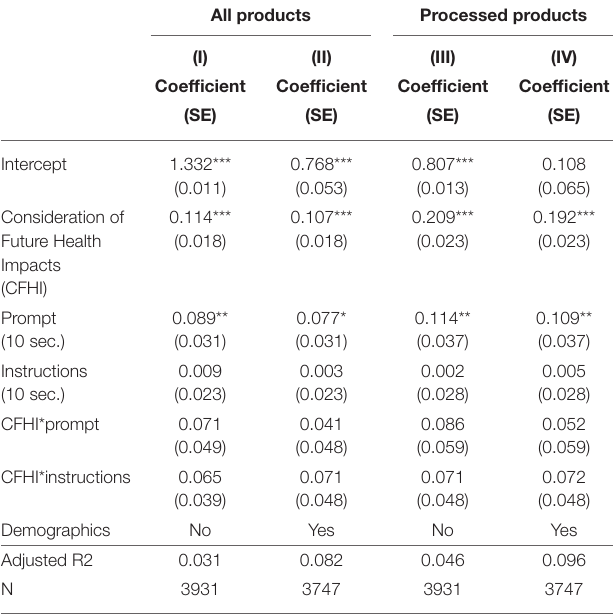
TABLE 6 | The impact of consideration of future health impacts and fiber prompt (10 second exposure) on average guiding stars of foods selected in food choice